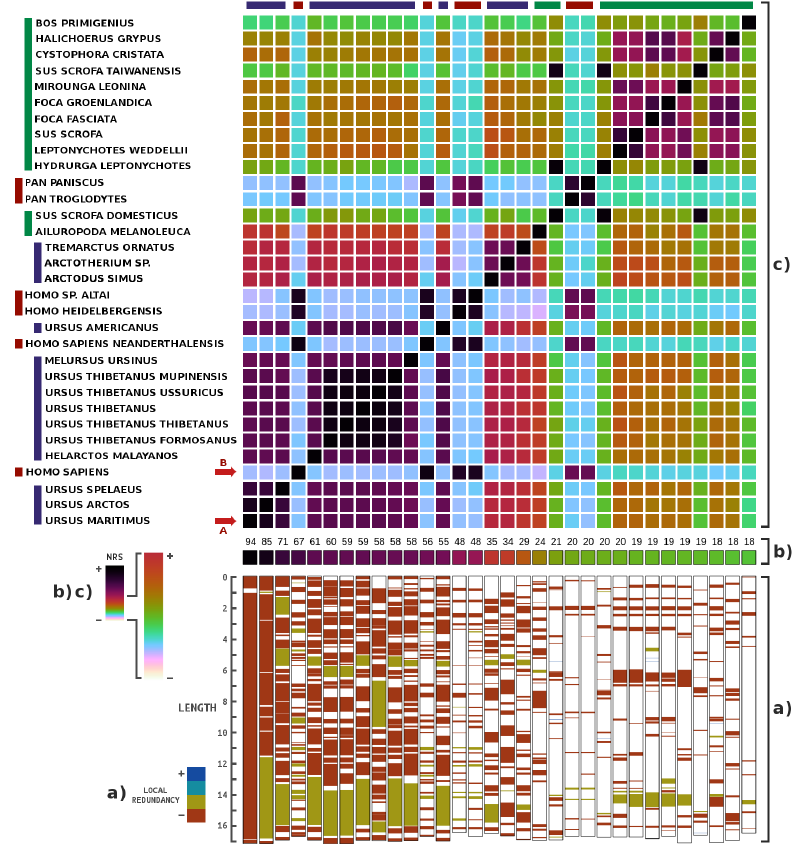
Figure 2. Metagenomic composition analysis of the PUM (Poolepynten Ursus maritimus ) sample, specifically for mitochondrial genomes: ( b ) the percentage of the highest NRS entries in descending order (from left to right), according to the order of the names on the left (from bottom to top); ( a ) locations where the mitochondrial genomes are similar relative to the reads, as well as their respective redundancies, mapped with four colours; and ( c ) intra-similarities of the mitochondrial genomes based on the NRS. The matrix appears to be symmetric because the sizes of the samples are approximately the same. Length is presented in 10 3 . Letters (in red) identify potential genomes contained in the